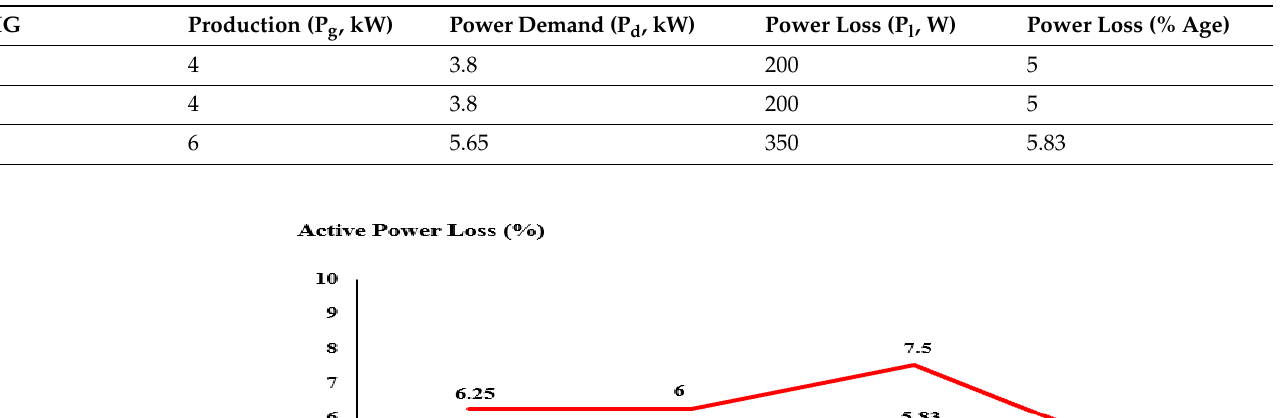
Table 9. Allocation of power and losses between MG1, MG2, and MG3 in islanding mode.